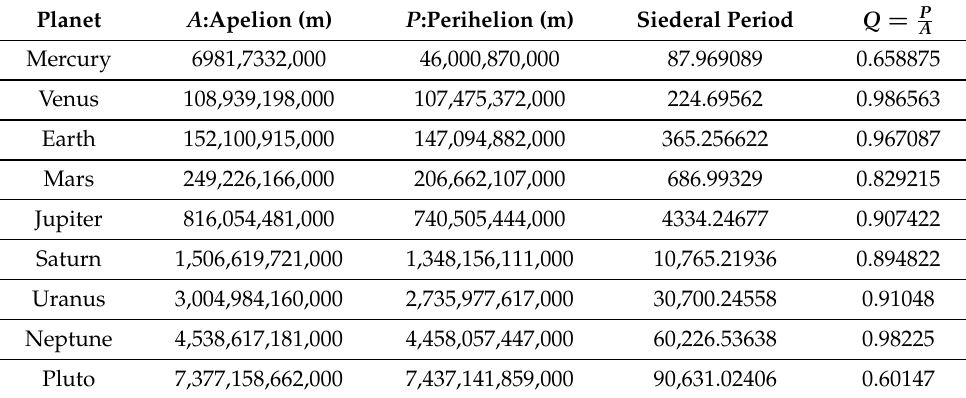
Table 2. Planets data. From